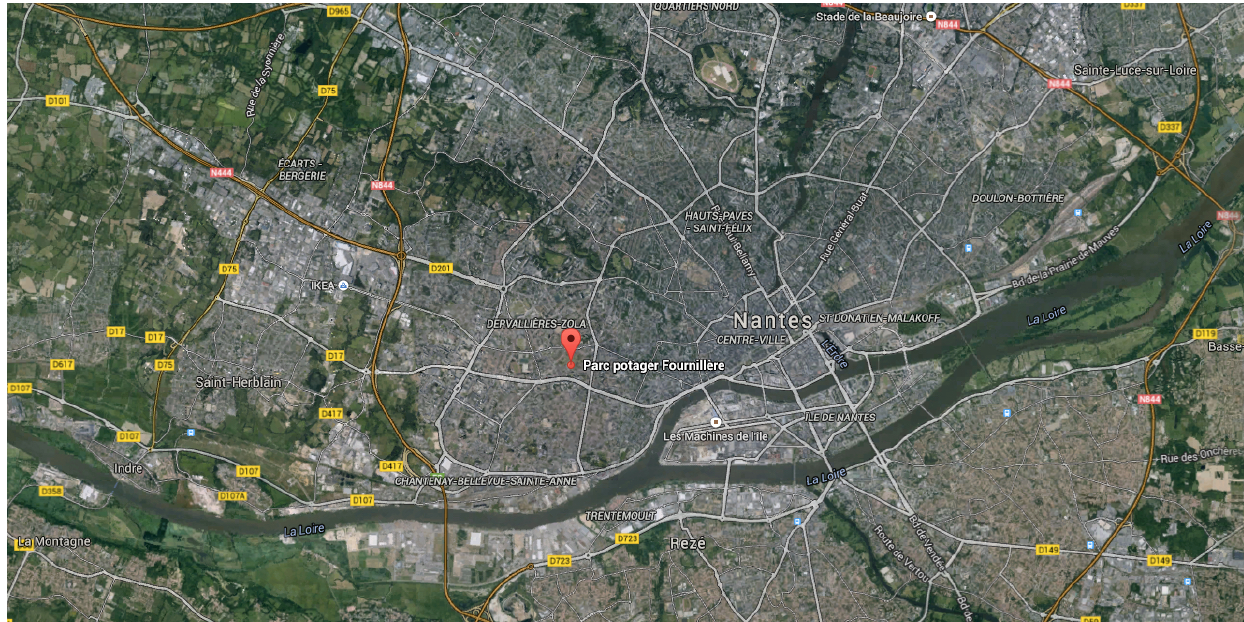
Figure 1. Situation map of La Fournilli`ere downtown Nantes. Source: Google